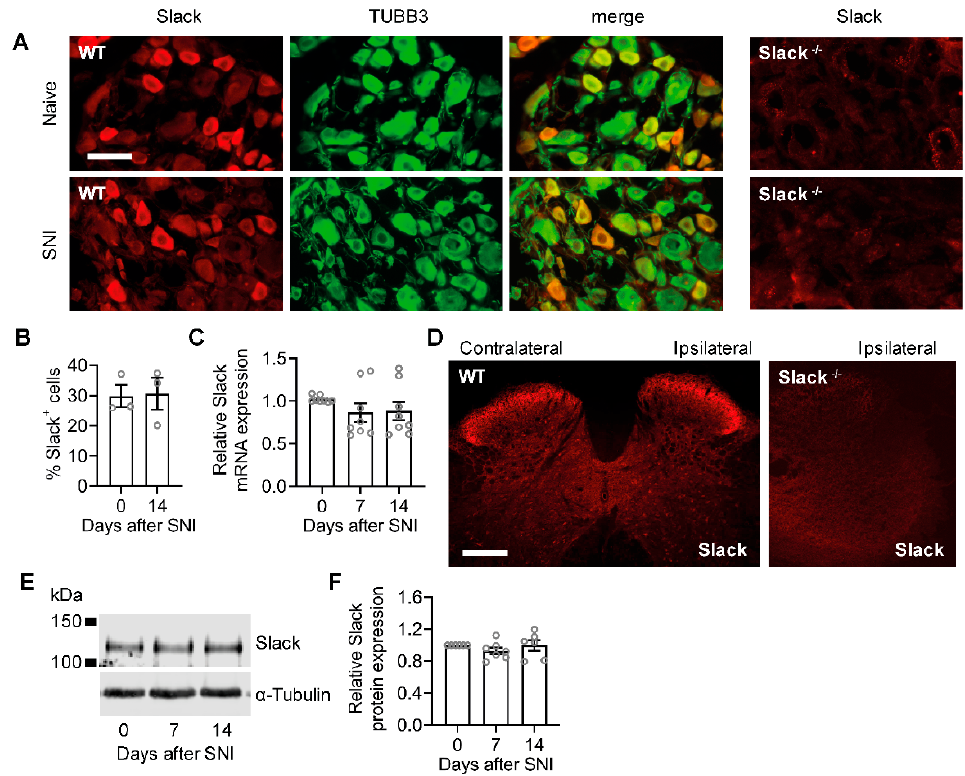
Figure 3. Unaltered Slack expression in WT mice after peripheral nerve injury. ( A , B ) Double-labeling immunostaining of Slack and the neuronal marker anti- β III-tubulin (TUBB3) in DRGs of naive WT mice and 14 days after SNI. Colocalization of Slack and TUBB3 appears in yellow. The staining suggests that Slack is exclusively localized to neurons and that its distribution is not altered in response to the injury. The absence of Slack immunoreactivity in DRGs of Slack -/- mice confirms the antibody specificity ( A ). The percentage of Slack-immunoreactive DRG neurons of all β III-tubulin-stained neurons is similar in naive mice and 14 days after SNI (( B ); 1833 and 1630 cells counted, respectively; n = 3 mice per group). Student’s t-test: p = 0.9130. ( C ), Quantitative RT-PCR experiments showed that Slack mRNA levels are not altered in DRGs 7 or 14 days after SNI as compared to naive control animals ( n = 8 mice per group). One-way ANOVA: p = 0.1433. ( D ), Immunostaining in the lumbar spinal cord of WT mice 14 d after SNI shows similar Slack expression in the ipsilateral and contralateral dorsal horn. The absence of Slack immunoreactivity in the spinal cord of Slack -/- mice confirms the antibody specificity. ( E , F ) A Western blot of spinal cord extracts shows similar Slack protein (140 kDa) expression in naive mice and 7 or 14 days after SNI surgery ( E ). Uncropped original image is shown in Figure S2A. Quantification is shown in ( F ). Alpha-tubulin was used as a loading control. One-way ANOVA: p = 0.4446. Bars denote mean ± SEM. Scale bars: 50 µ m ( A ), 200 µ m ( D